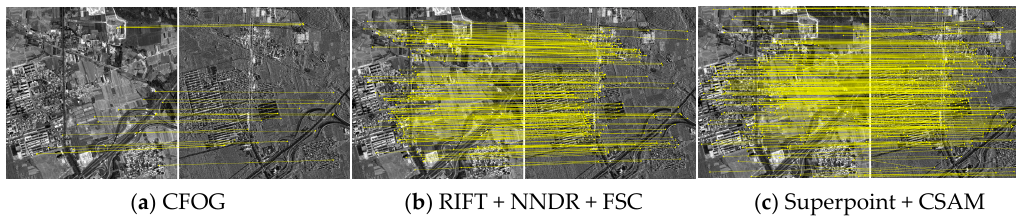
Figure 16. Optical–SAR matching results.